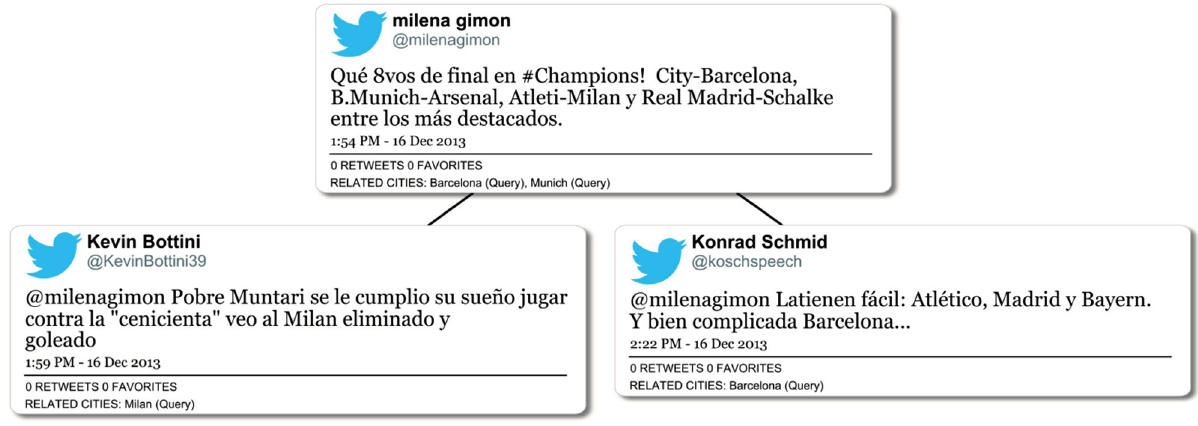
Figure 8. Example conversation related to Milan, Barcelona and